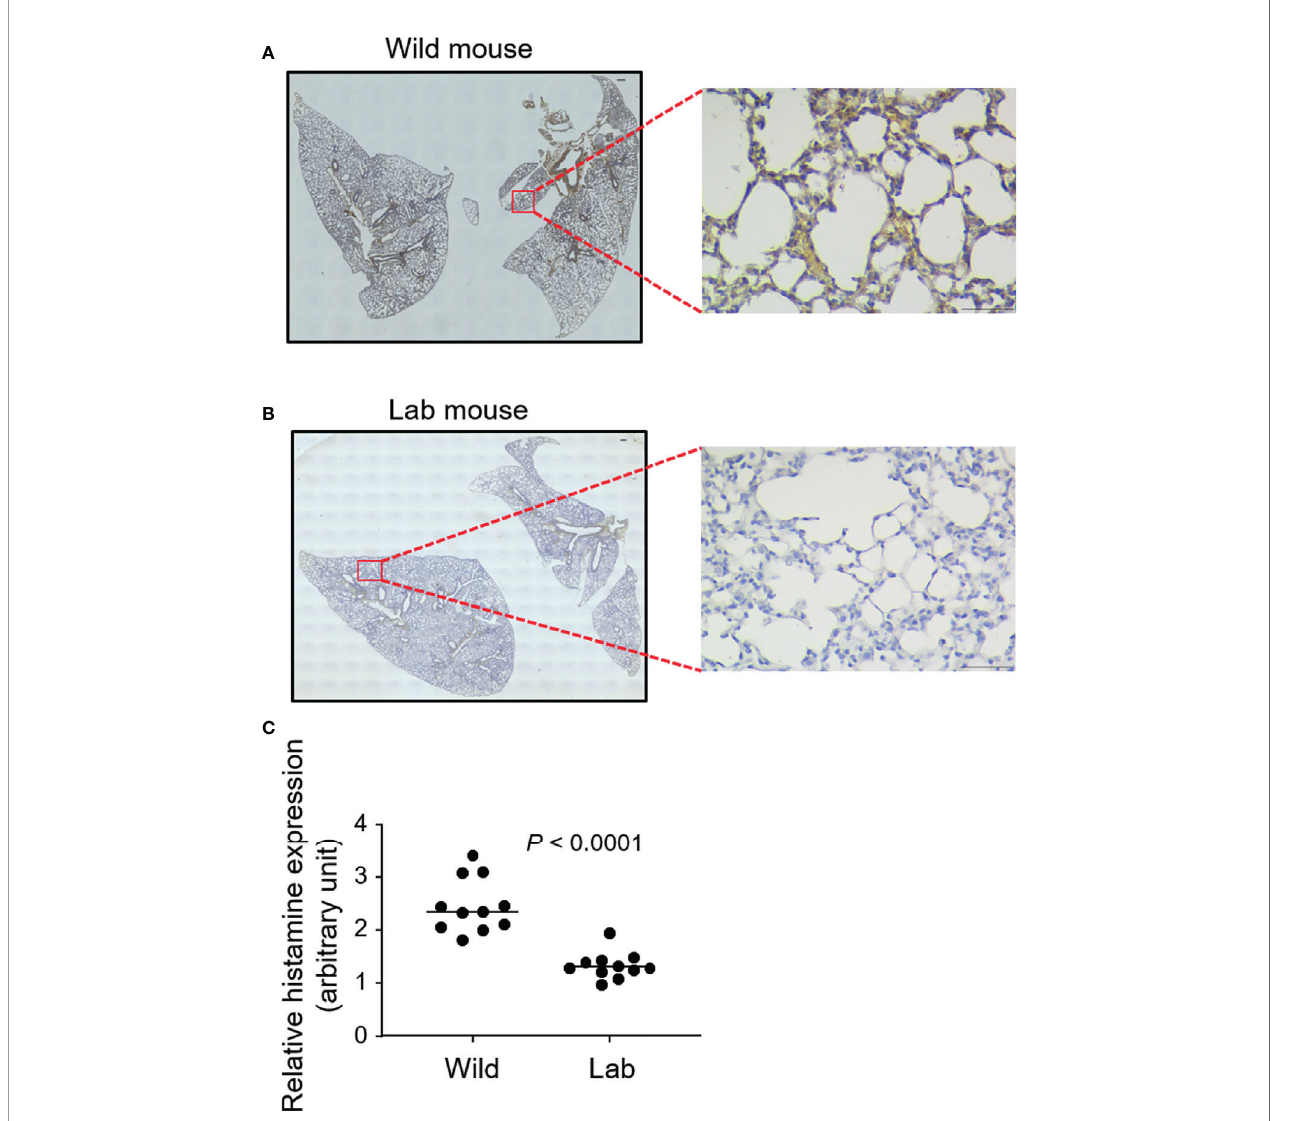
FIGURE 2 | Wild mouse lungs express higher levels of histamine. Free-living wild mice were trapped at Hemtabad, India ( n = 11) and their lung tissues (A) , together with laboratory (lab) mouse (C57BL/6) controls ( n = 11) (B) , were processed and sectioned, followed by peroxidase-based immunostaining using an antihistamine antibody. Magni fi ed views of the highlighted regions are shown. At least three randomly chosen areas were scanned for determining the intensity of histamine which was expressed as optical density (OD) per area (C) . Each dot represents an individual mouse and horizontal lines indicate the median. Scale bar: 200 m m or 50 m m (magni fi ed